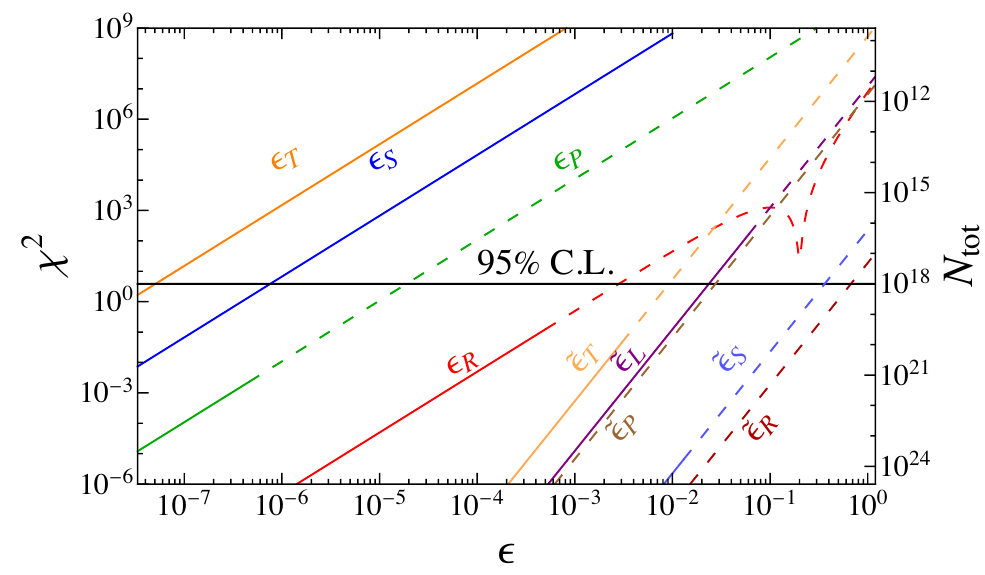
Figure 8 . χ 2 deviation for exotic current contributions as a function of the relevant coupling constant, using the tritium energy distribution. The curves are plotted in solid below the coupling constant’s upper bound (cf. table 2) and dashed above. The horizontal black line is the 95 % CL sensitivity for N tot = 10 18 events, while the N tot scale on the right-hand axis shows the number of events required to reach a 95% CL sensitivity. The labels denote the relevant coupling constant contributing at a